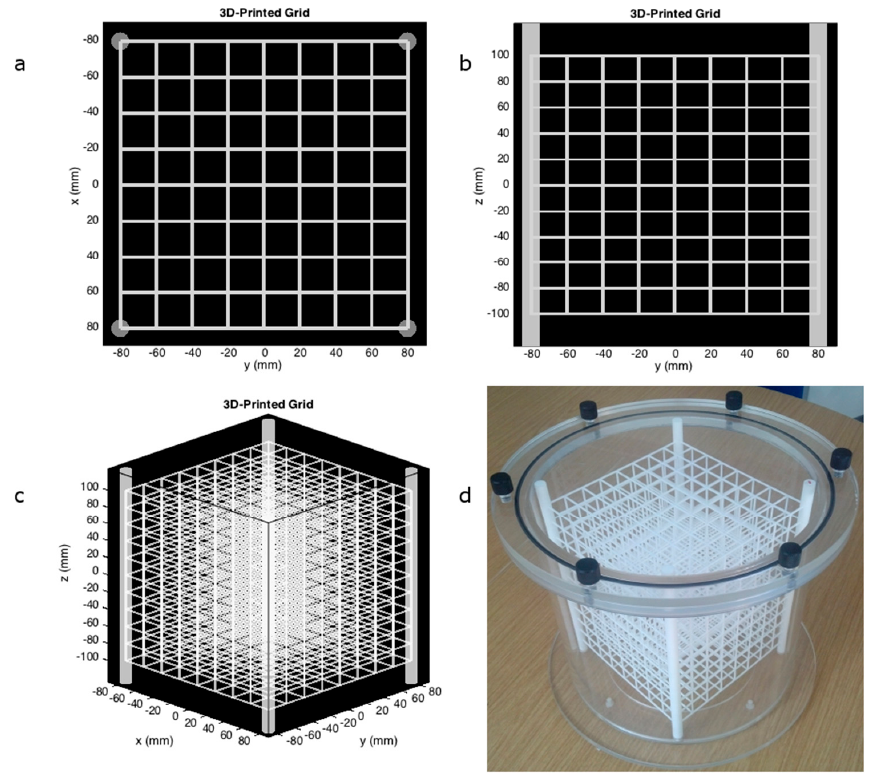
Figure 1. 3D-printed grid in white and strong plastic ( a ) axial view, ( b ) sagittal view, ( c ) perspective view (azimuth 45°, elevation 20°), and ( d ) photograph of the grid fixated inside a leak-tight container.